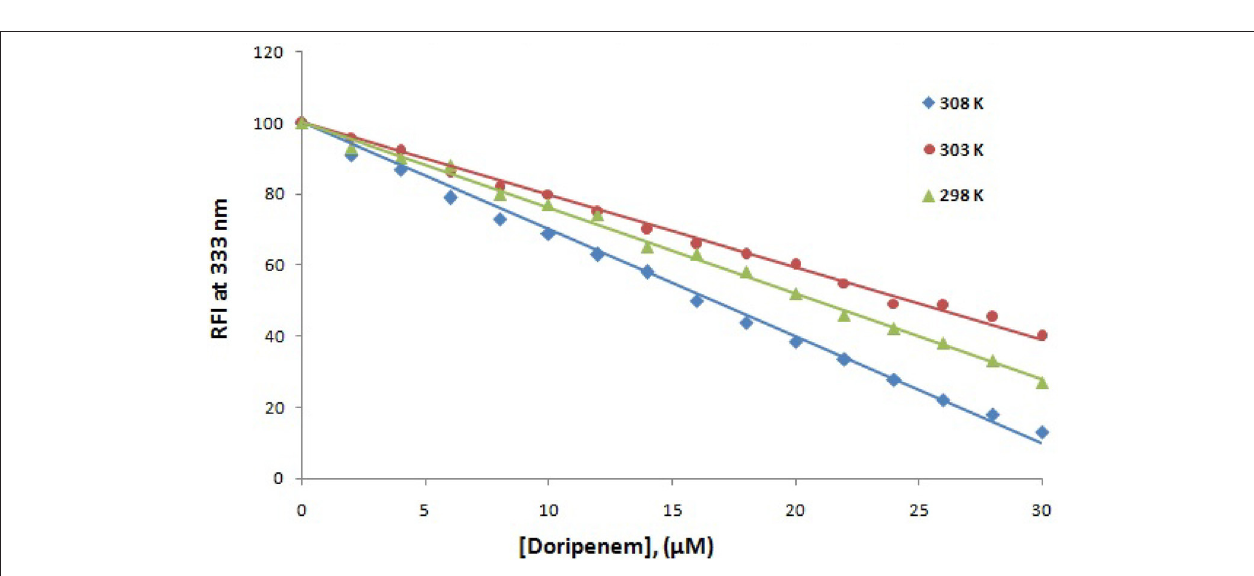
FIGURE 5 | The decrease in relative fluorescence intensity (RFI) of CTX-M-15 (2 µ M) in the presence of doripenem (0 to 30 µ M ) at 298, 303, and 308K in 50 mM sodium phosphate buffer at pH 7.4 is